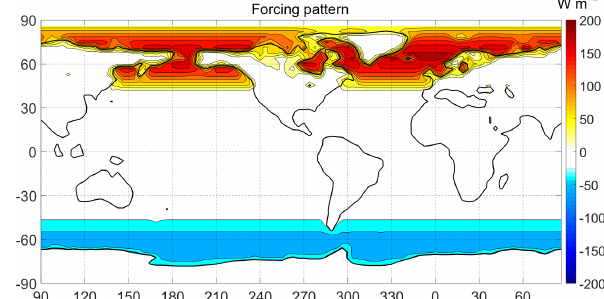
Figure 3. Forcing pattern. The sign convention is positive out of sea. Contour interval 20Wm − 2